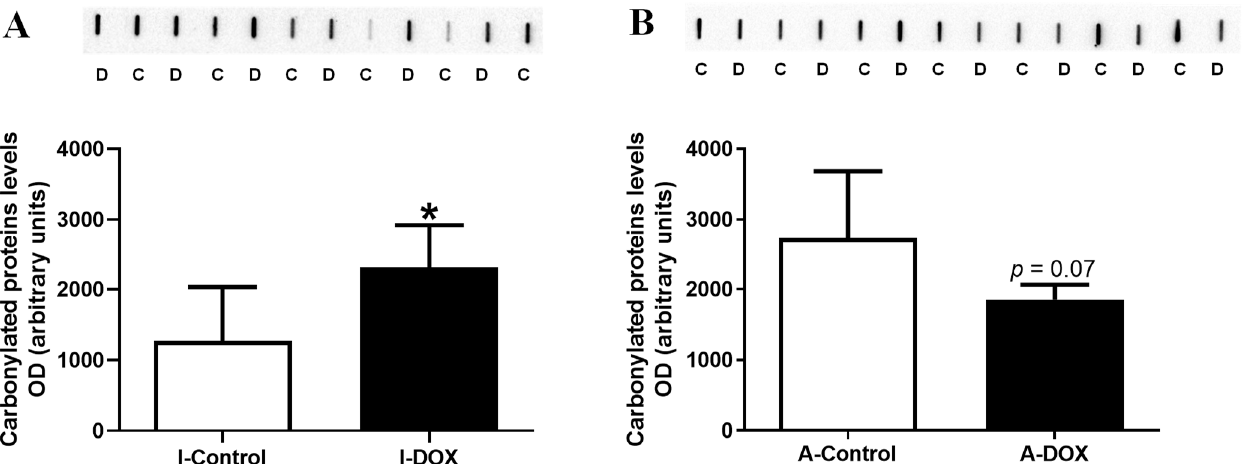
Figure 5. Protein carbonylation cardiac lysate content evaluated by slot blot in ( A ) infant DOX-treated (I-DOX) and control mice (I-Control), and ( B ) adult mice exposed to a cumulative dose of 18.0 mg/kg DOX (A-DOX) and respective controls (A-Control). Values are expressed as mean ± SD and were obtained from 6 infant or 7 adult animals from each treatment group. Statistical comparisons were made using Student’s t -test: * p < 0.05, DOX 18 mg/kg vs. control. OD: optic density; D: DOX and C: Control.